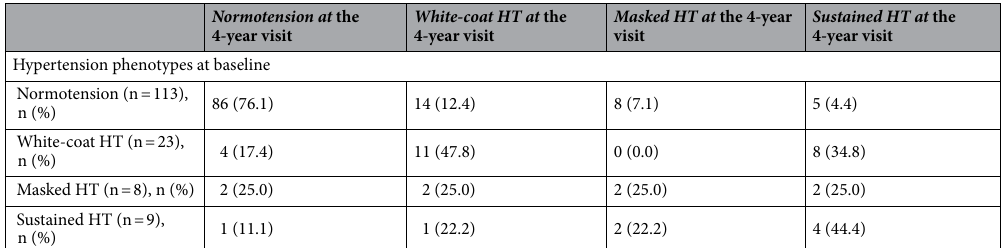
Table 2. Agreement among hypertension phenotypes. HT